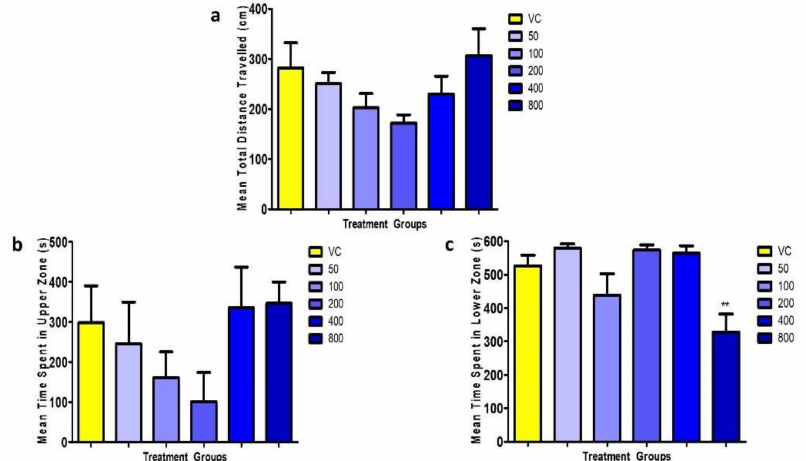
Figure 3. Mean locomotion parameters over 600 s for all the experimental groups. Figure ( a ) represents the mean total distance travelled (cm), Figure ( b ) shows the mean time spent in upper zone (s) and Figure ( c ) displays the mean time spent in lower zone (s). The data are expressed as Mean ± SEM, n = 8 and was analyzed using One-way ANOVA followed with Dunnett’s post-hoc test at significance level of ** p < 0.01 against the VC group (tank water only,